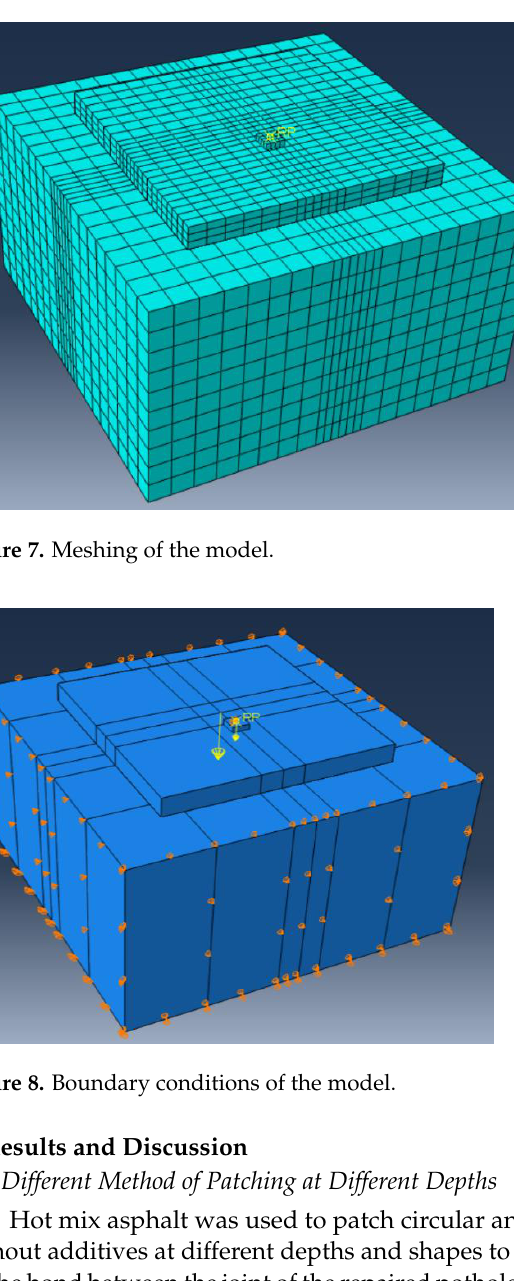
Figure 8. Boundary conditions of the model. Table 11. Mechanical properties of pavement layers.